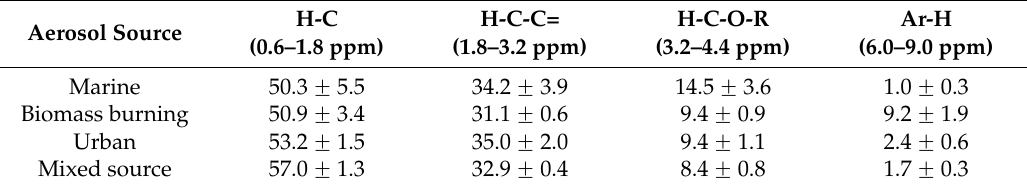
Figure 4. 1 H NMR spectra for WSOM of ( a ) marine; ( b ) biomass burning; ( c ) urban; and ( d ) mixed source aerosols, where each colored line represents a different sample spectrum. The region between 6 and 9 ppm represents aromatic protons, and is expanded in the inset of each spectrum. Table 4. Average relative contributions of total spectral intensity for integrations of major proton regions in 1 H NMR spectra for each of the aerosol sources. Standard deviations of the relative signal in each region among aerosols from the same source are provided.